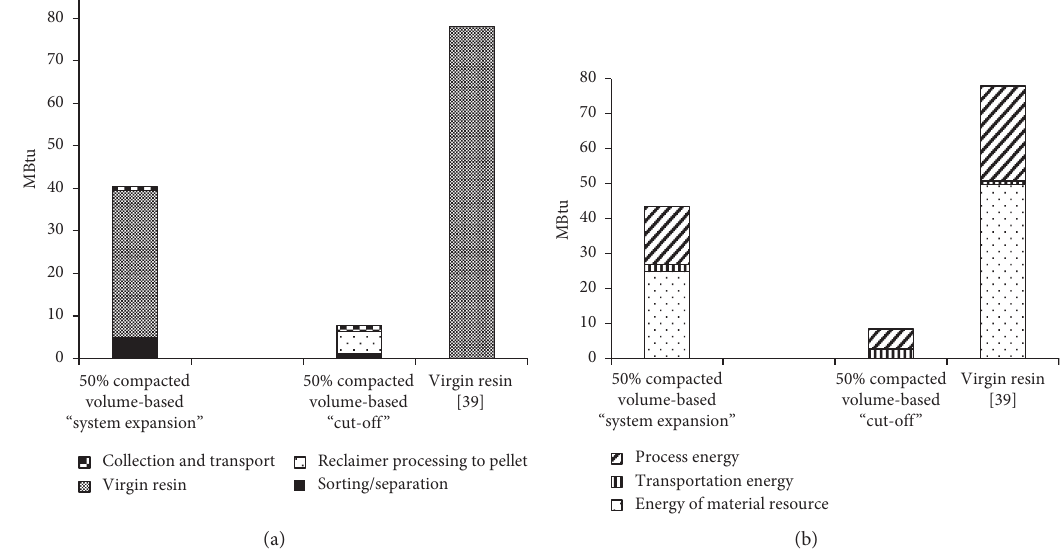
Figure 3: Energy results for production of the recycled HDPE resin pellet (million Btu per ton of resin) by the (a) life cycle stage and (b) energy